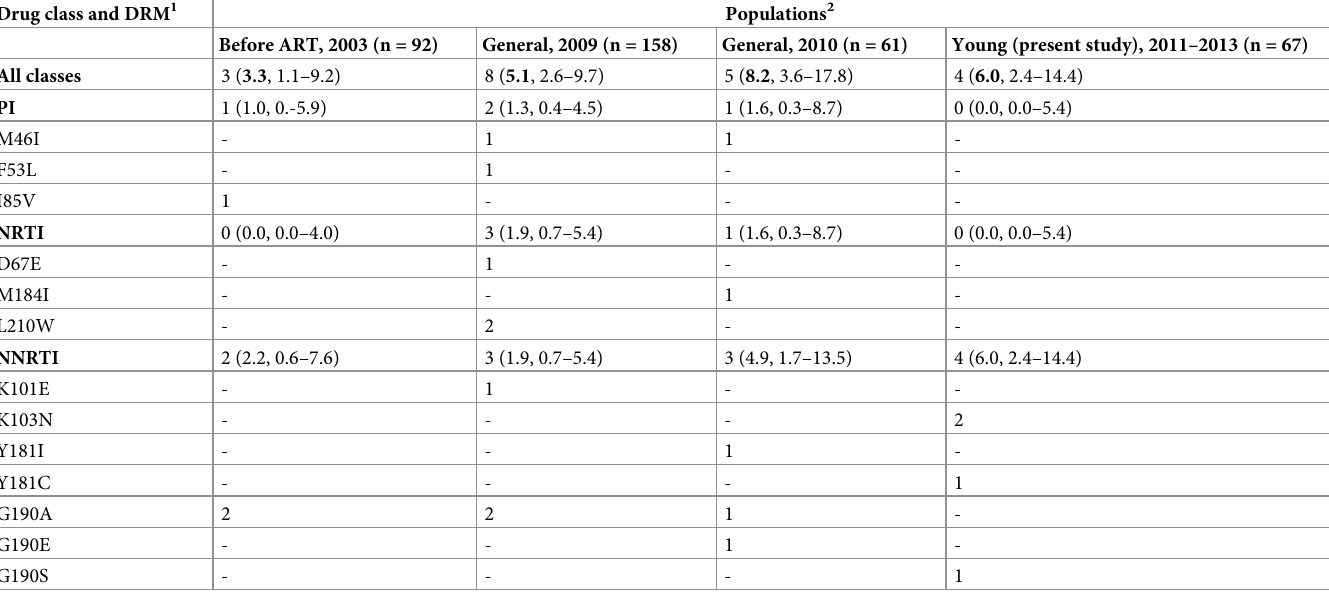
Table 1. Prevalence of HIV drug resistance mutations in Gondar 2003–2013.